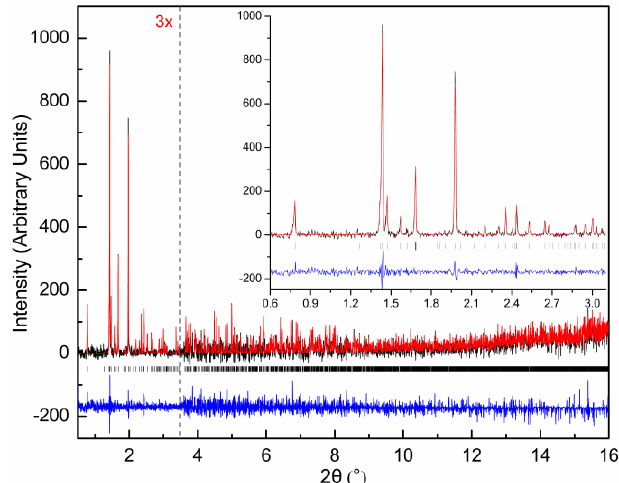
Figure 5. Pawley fit of synchrotron XRPD data of DENV3 NS5 MTase (pH 8.5; space group P 2 1 2 1 2, a = 61.8934 (7) Å, b = 189.517 (2) Å, c = 52.4404 (6) Å, R wp = 11.413% and χ 2 = 0.7506). Data were collected on ID22-ESRF (RT, λ = 1.299995 (3) Å). The black, red and blue lines represent the experimental data, the calculated pattern and the difference between the experimental and calculated profiles, respectively. The vertical bars correspond to Bragg reflections compatible with space group P 2 1 2 1 2 [72].